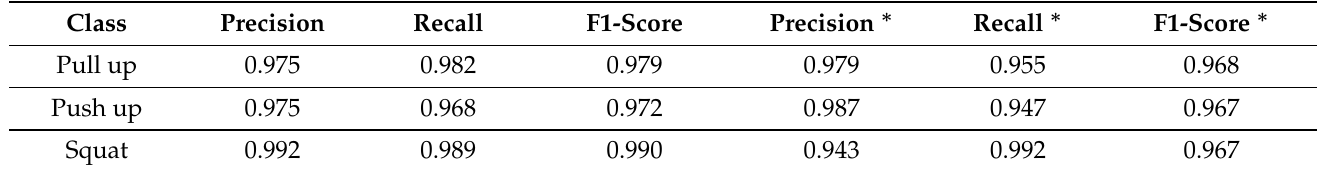
Table 5. Comparison with paper [19] over 3 exercises: pull up, push up and squat. The metrics with ∗ denotes the result of this paper while the metrics without ∗ represent the accuracy of paper